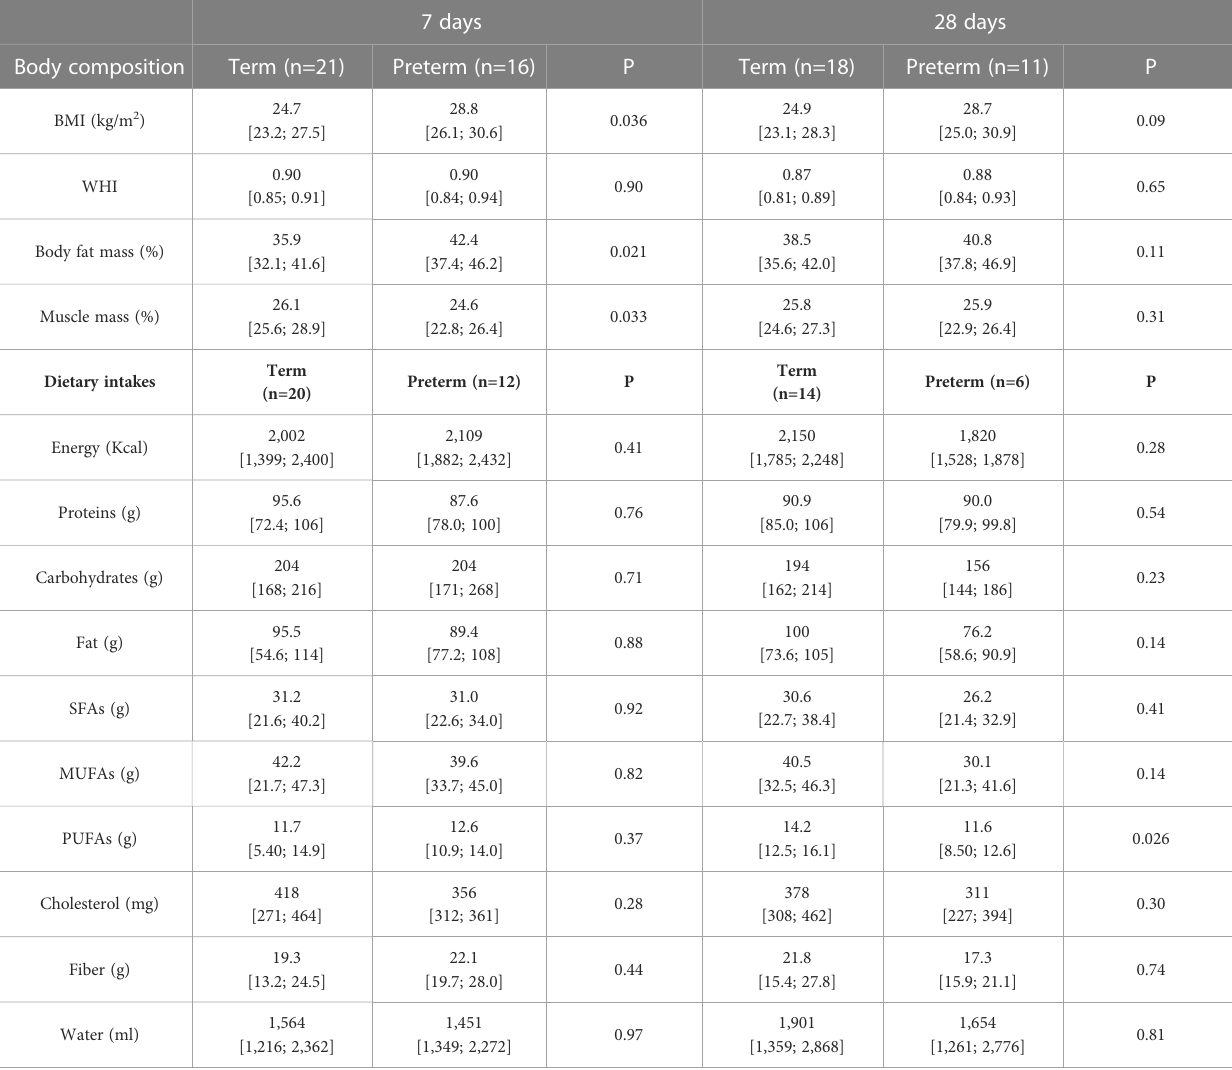
TABLE 2 Maternal body composition and dietary intakes between groups in the fi rst month of